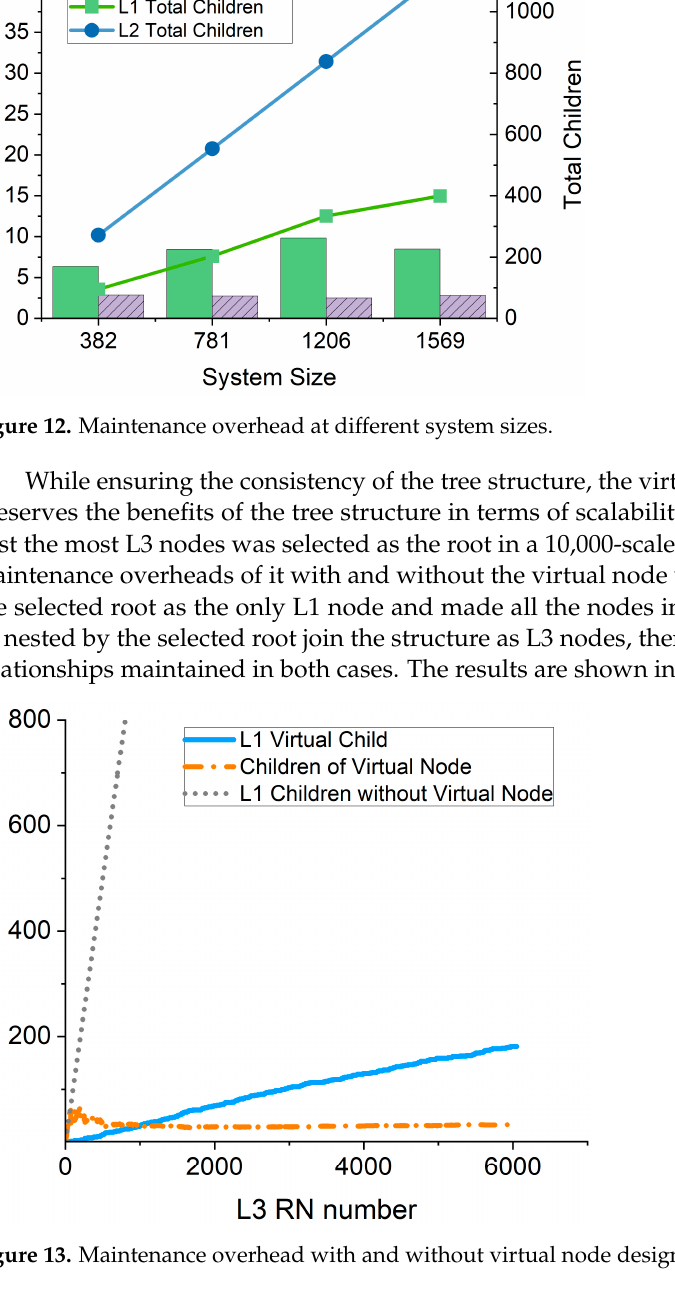
Figure 13. Maintenance overhead with and without virtual node design.